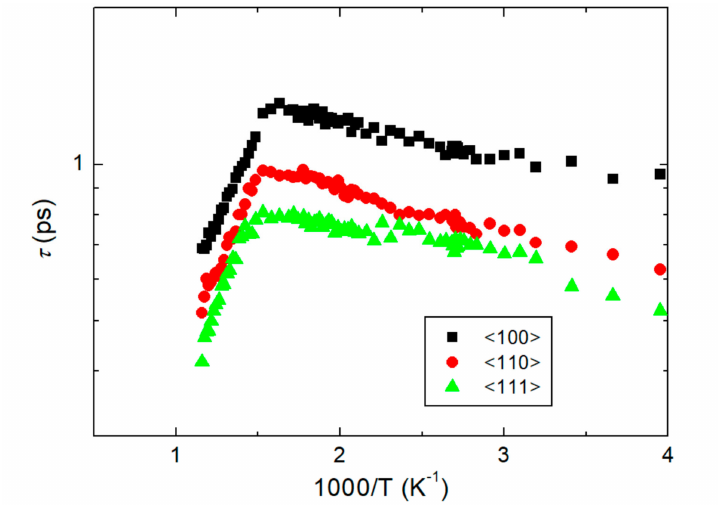
Figure 6. Relaxation time estimated by using Equation (3) for the three crystallographic